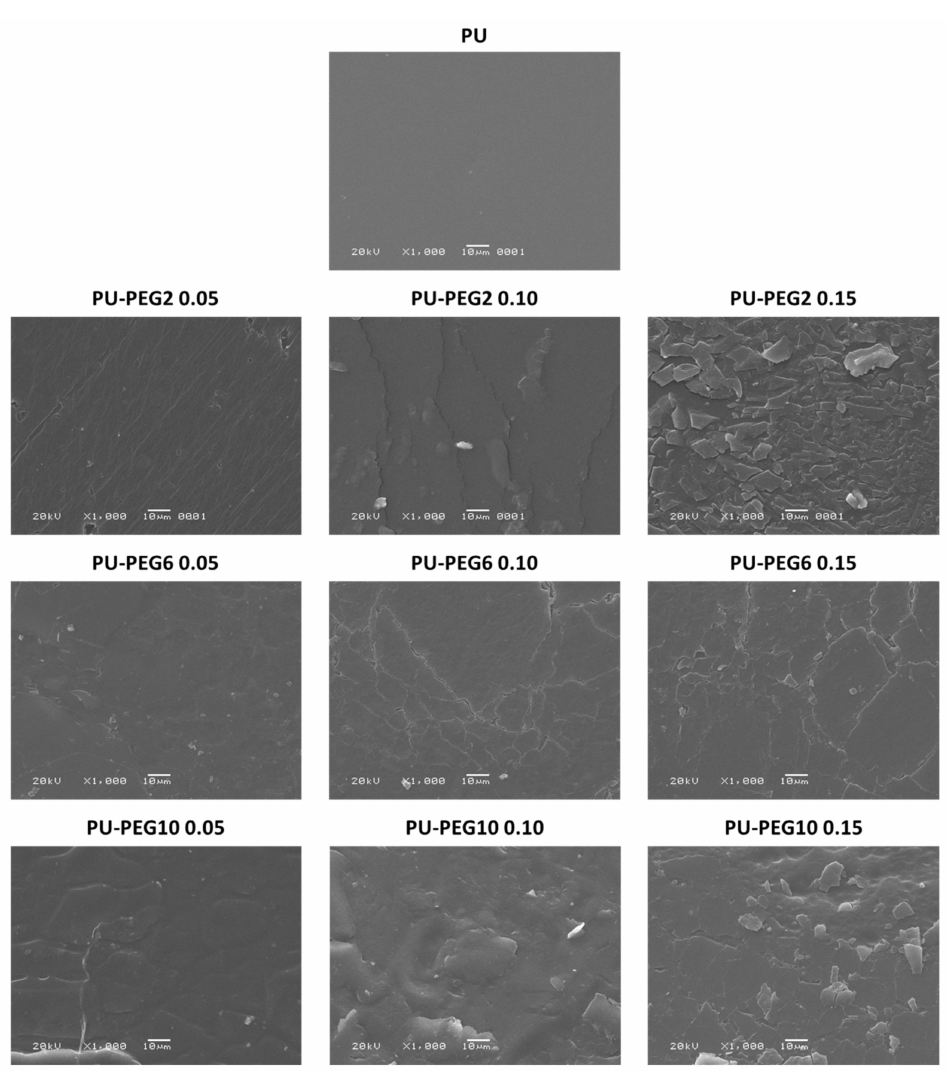
Figure 3. SEM images of the PU substrata. A PEG covering is formed on the surface of the